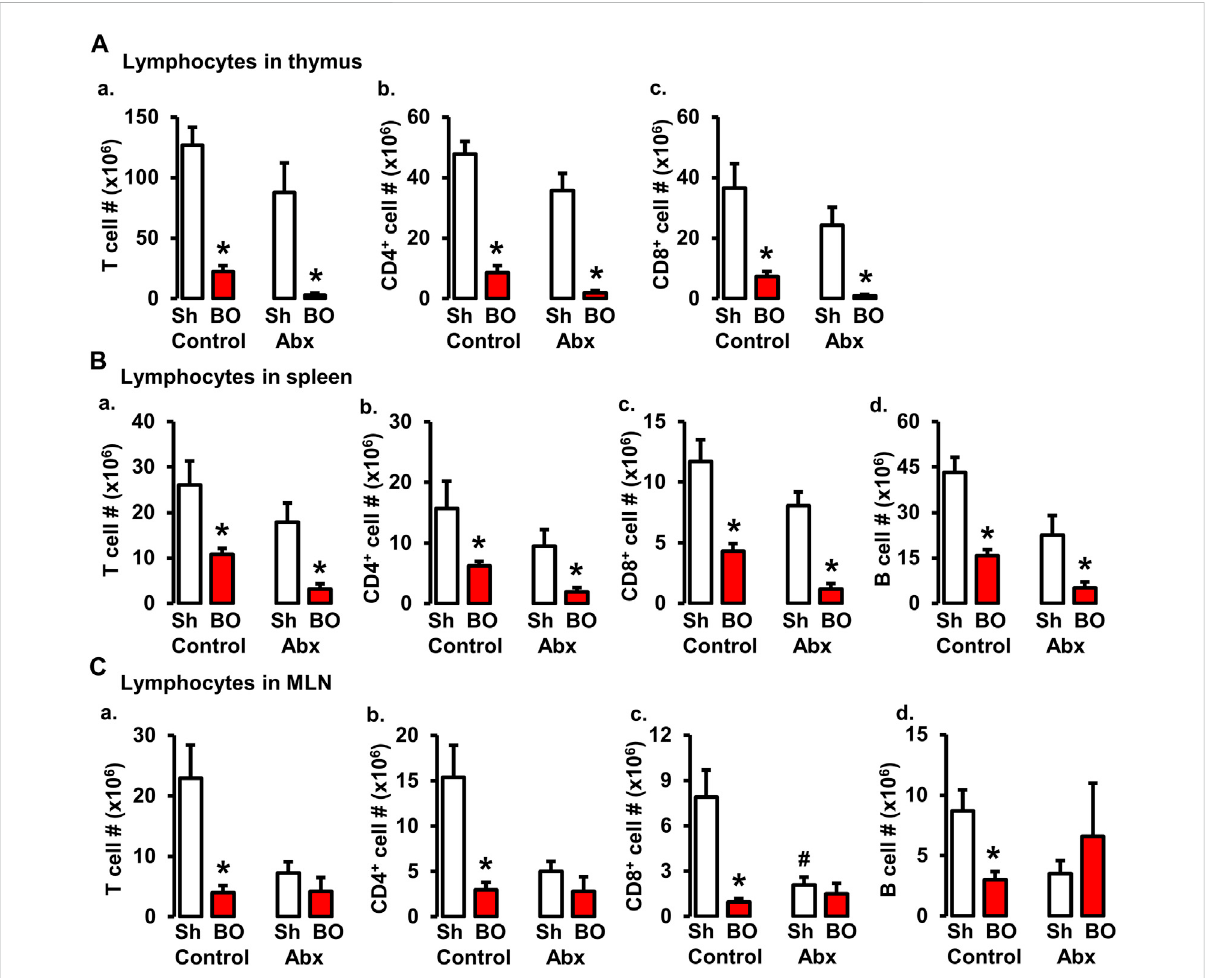
FIGURE 6 Role of gut microbiota in BO-associated lymphopenia in lymphoid organs. (A) Numbers of total T cells (A) , CD4 + cells (B) , and CD8 + cells (C) in the thymus in sham (Sh) and obstruction (BO) rats in control (no antibiotics treatment) and with antibiotics treatment (Abx). (B) Numbers of total Tcells (A) , CD4 + cells (B) ,CD8 + cells (C) ,and Bcells (D) inthespleen inShand BOrats incontrol and with Abxtreatment. (C) Numbers oftotal Tcells (A) ,CD4 + cells (B) ,CD8 + cells (C) ,andBcells (D) intheMLNinShandBOratsincontrolandwithAbxtreatment.N=5or6.* p ≤ 0.05vs.shamin the treatment group. # p ≤ 0.05 vs. sham in the control